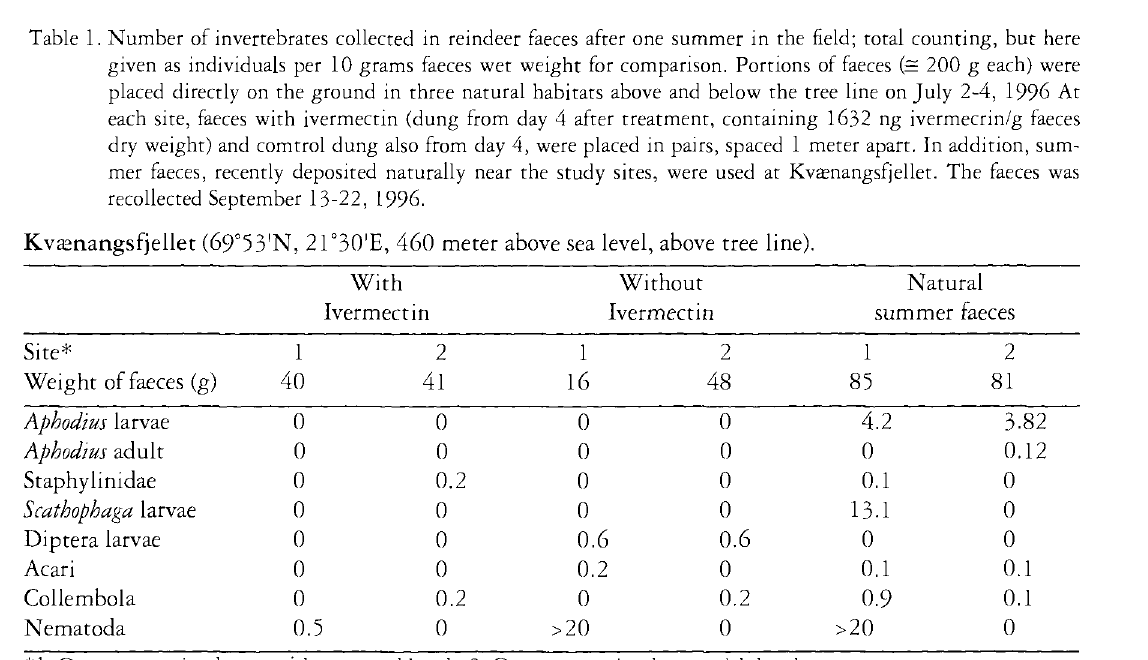
Table 1. Number of invertebrates collected in reindeer faeces after one summer in the field; total counting, but here given as individuals per 10 grams faeces wet weight for comparison. Portions of faeces (= 200 g each) were placed directly on the ground in three natural habitats above and below the tree line on July 2-4, 1996 At each site, faeces with ivermectin (dung from day 4 after treatment, containing 1632 ng ivermecrin/g faeces dry weight) and comtrol dung also from day 4, were placed in pairs, spaced 1 meter apart. In addition, sum mer faeces, recently deposited naturally near the study sites, were used at Kvaenangsfjellet. The faeces was recollected September 13-22, 1996.